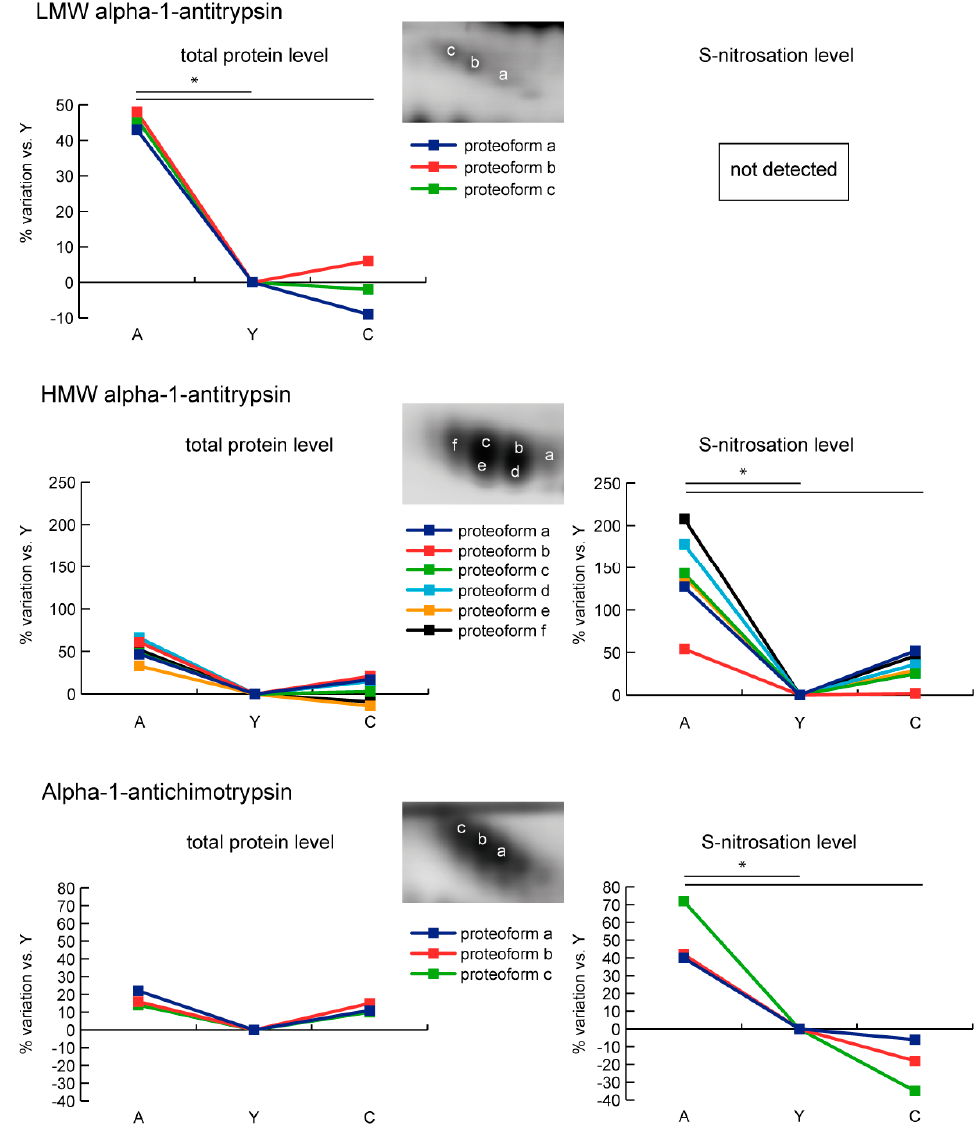
Figure 3. Line charts illustrating alpha-1-antitripsin (SERPINA1) and alpha-1-antichimotripsin (SERPINA3) proteoform abundance and S-nitrosation level variations (%) in sera of aged (A) and centenarian (C) compared to young (Y) women. Proteins were divided according to the statistical significance of the test (* = significant difference, ANOVA and Tukey, n = 6 (2-D DIGE) or n = 9 (Nitro-DIGE), p -value < 0.01).